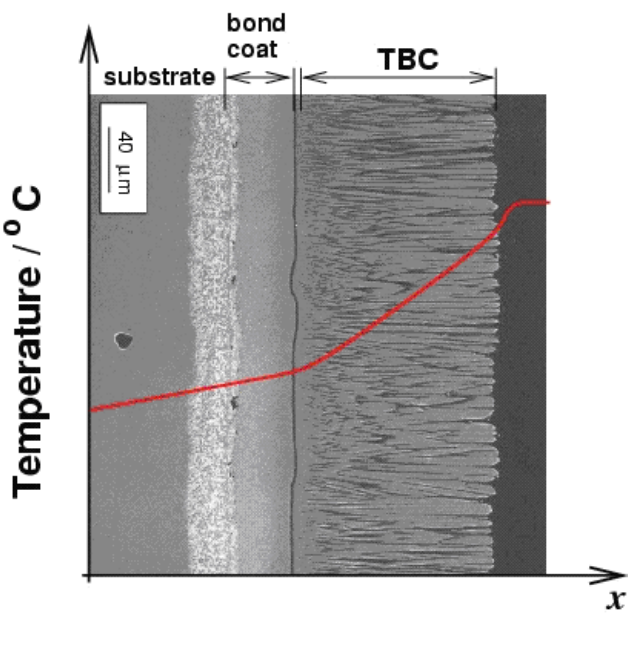
Figure 67. Temperature variation across the section of a TBC deposited on a substrate [105].